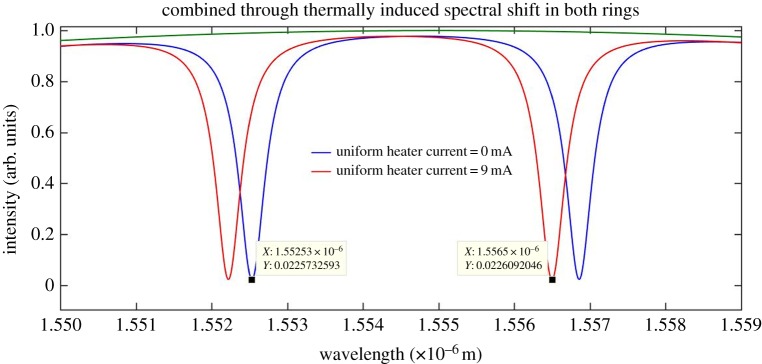
Expanded spectrum of figure 15.